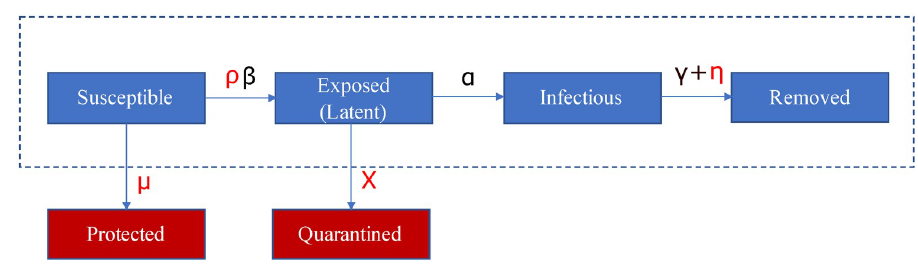
Fig 1. Scheme of the SPQEIR model. The basic SEIR model (framed blue blocks) is extended by the red blocks to the SPQEIR model. Parameters that are linked to mitigation strategies are shown in red. Interpretation and values of parameters are given in Table